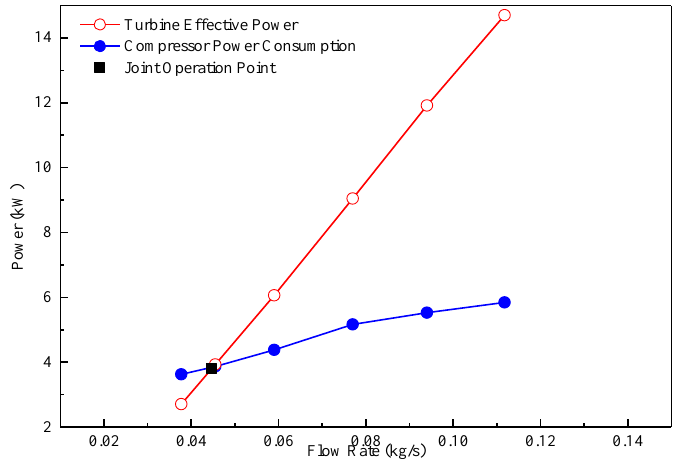
Figure 8. Definition of the power balance at 150,000 rpm.